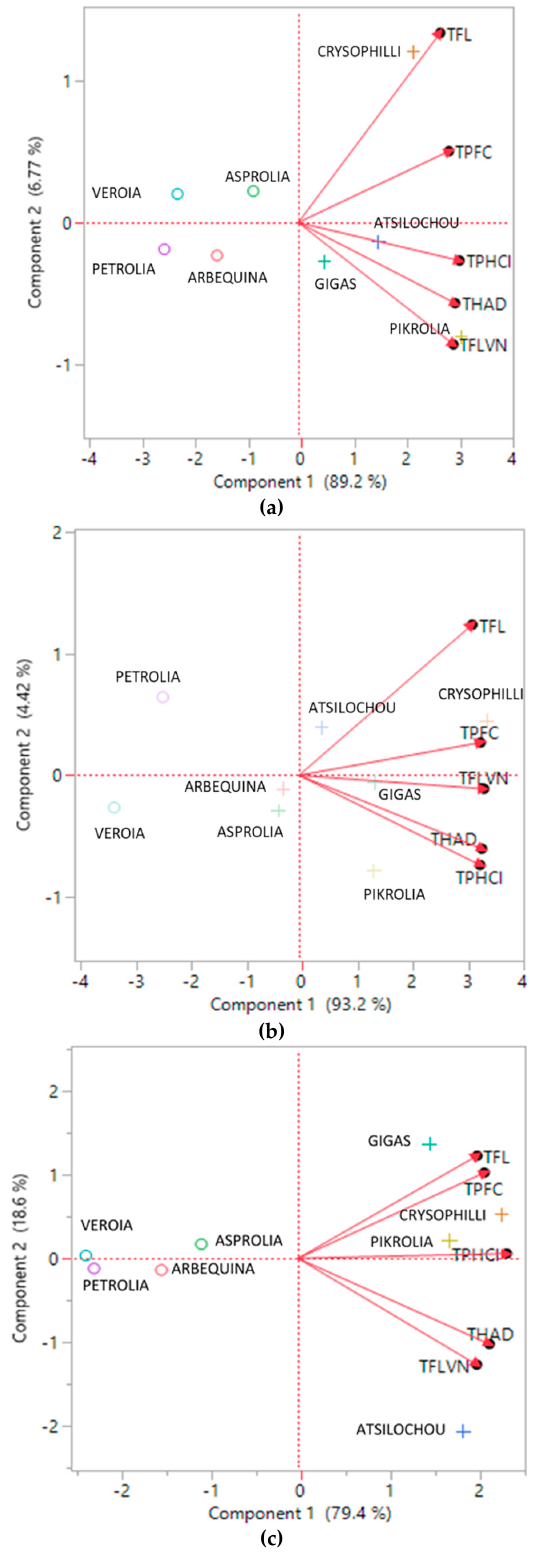
Figure 5. PCA biplots summarizing the relationship between the studied parameters and the olive leaf varieties. ( a ), ( b ), and ( c ) depict data from the aqueous, methanol, and ethanol extracts, respectively. TPFC, total phenols determined via the Folin–Ciocalteu assay; TPHCl, total phenols determined via the alternative spectrophotometric assay; THAD, total hydroxycinnamic acid derivatives; TFLVN, total flavonols; TFL, total